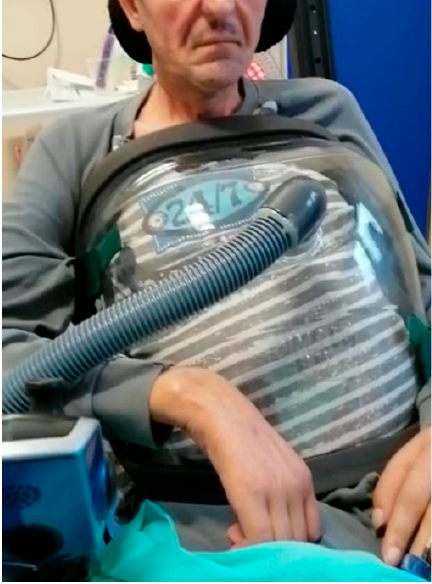
Figure 1. A patient with ALS during NPV.